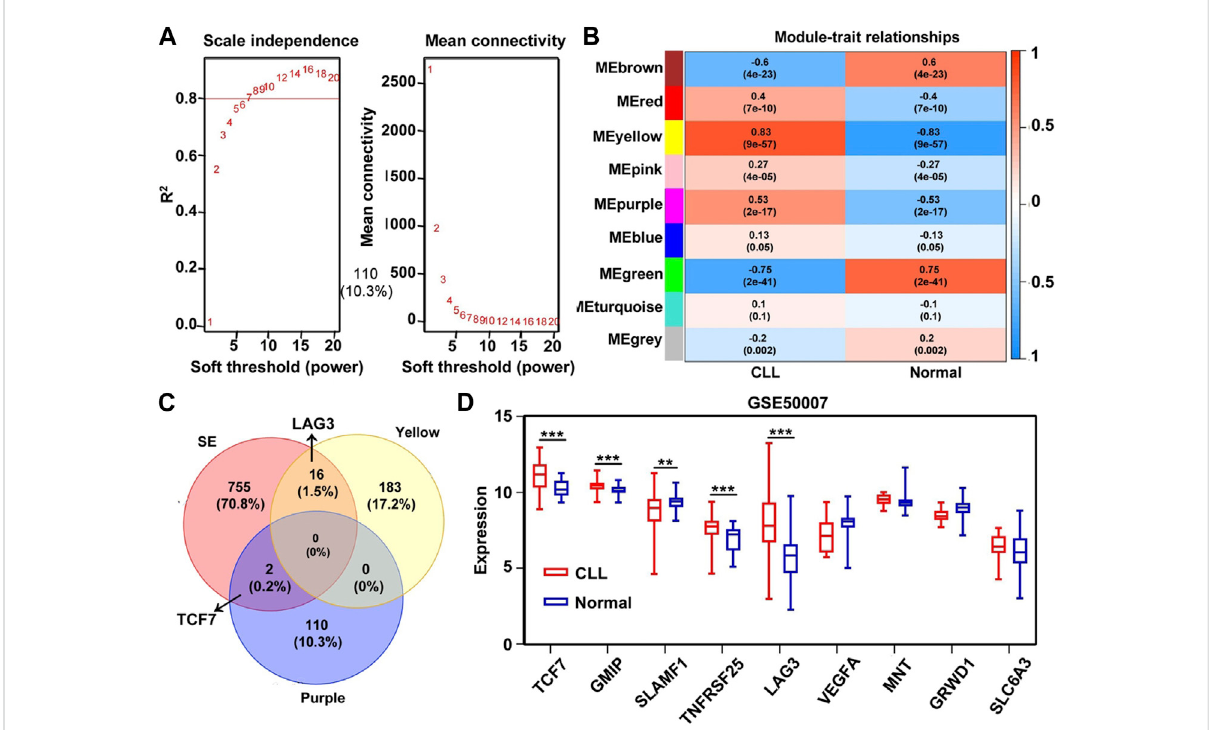
FIGURE 5 Identi fi cation of SE-related hub gene in CLL based on GSE50006 dataset through WGCNA analysis. (A) Analysis of the scale independence and meanconnectivity(vertical axis)for various soft-thresholding powers( β valueofhorizontalaxis). (B,C) Heatmap ofthecorrelationbetweenmodules and CLL. The yellow and purple module had a high correlation with CLL patients, and the p -value in the table speci fi ed the correlation. TCF7 and LAG3 appeared in the intersection of SE-related genes and the two modules, respectively. (D) The nine hub genes ’ expression was signi fi cantly different between normal and CLL patients in the GSE50006 dataset. ** p < 0.01; *** p <